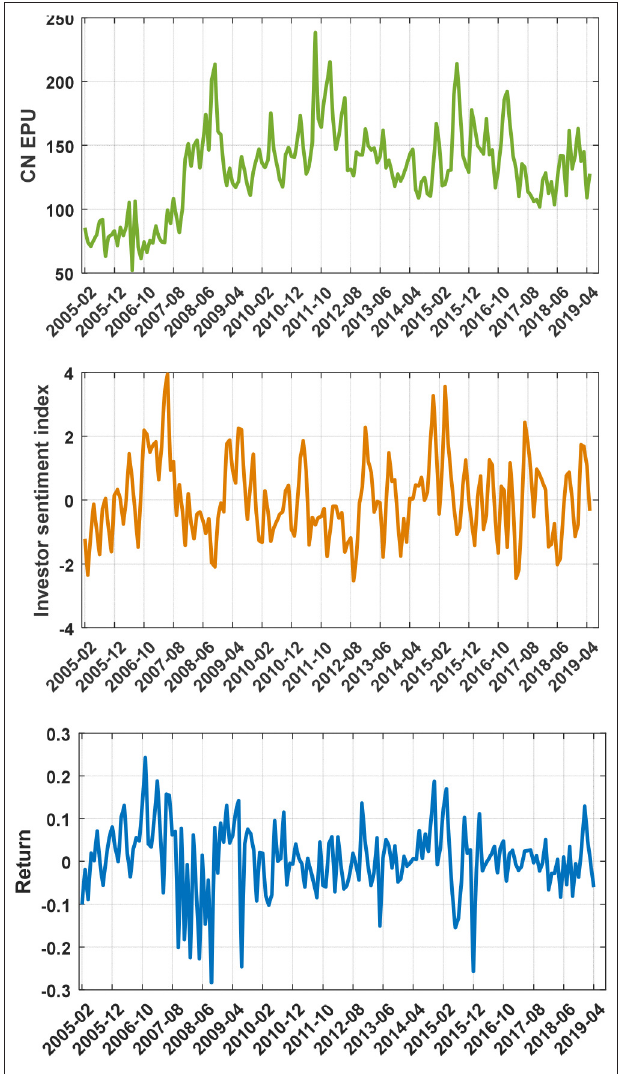
FIGURE 1 | Time series of the CN EPU index, Investor sentiment and Return of the Shanghai Composite Index’s closing price.